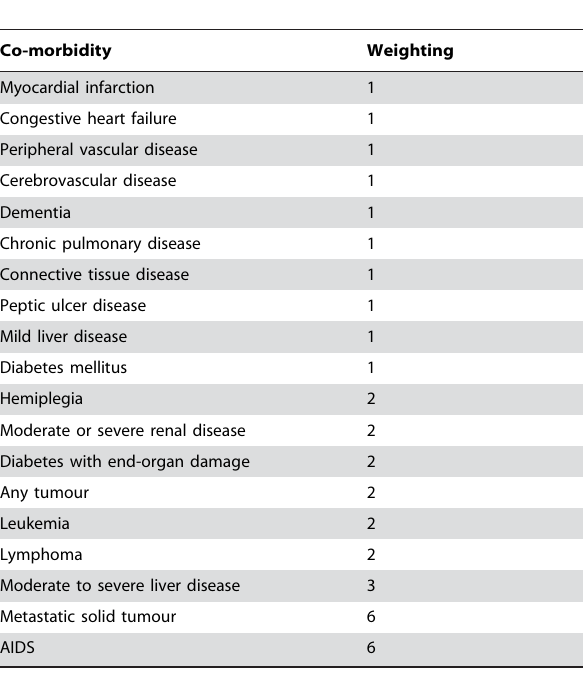
Table 1. Charlson co-morbidity index component and its